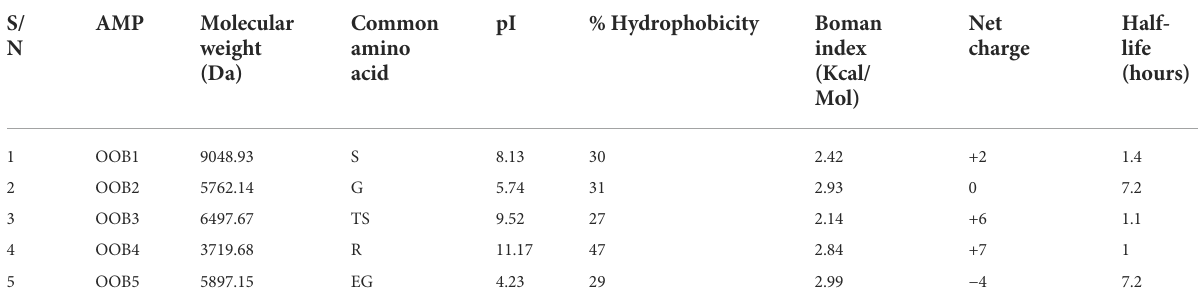
TABLE 5 Physicochemical properties of the anti- Fusarium solani AMPs. S/ N